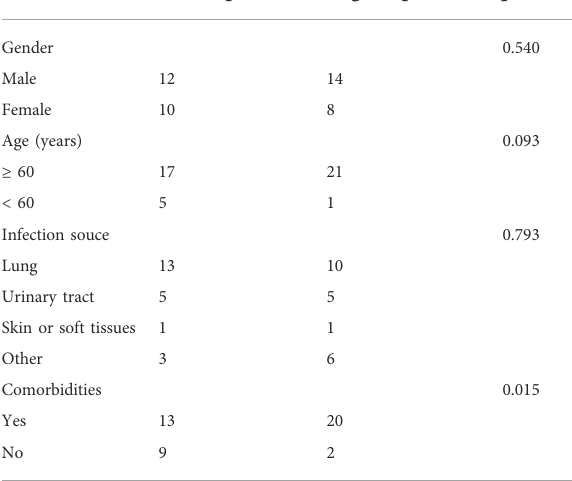
TABLE 3 Demographic information for sepsis patients according to hsa_circ_0074158 expression.